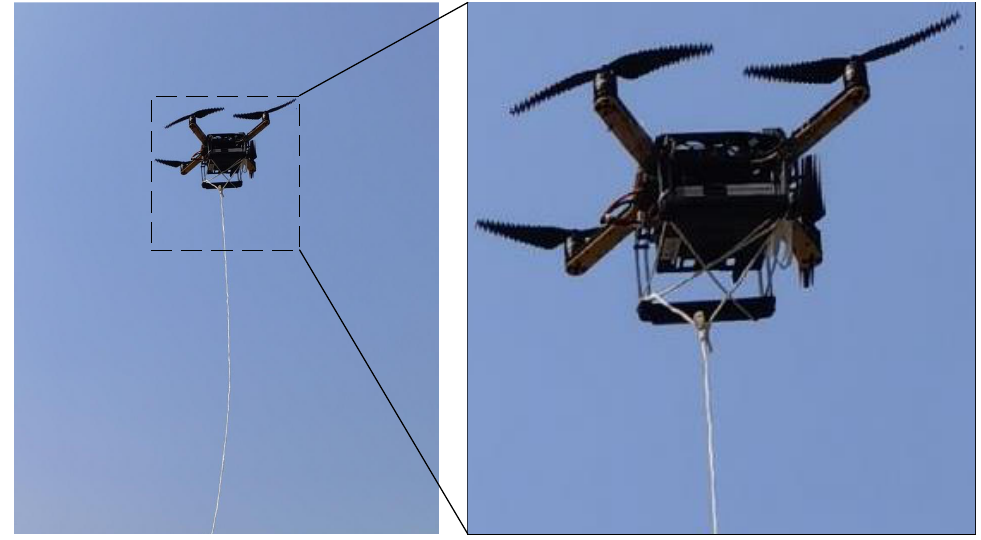
Figure 7. An actual experimental attack picture: a nylon cord is fastened to the bottom of the UAV.